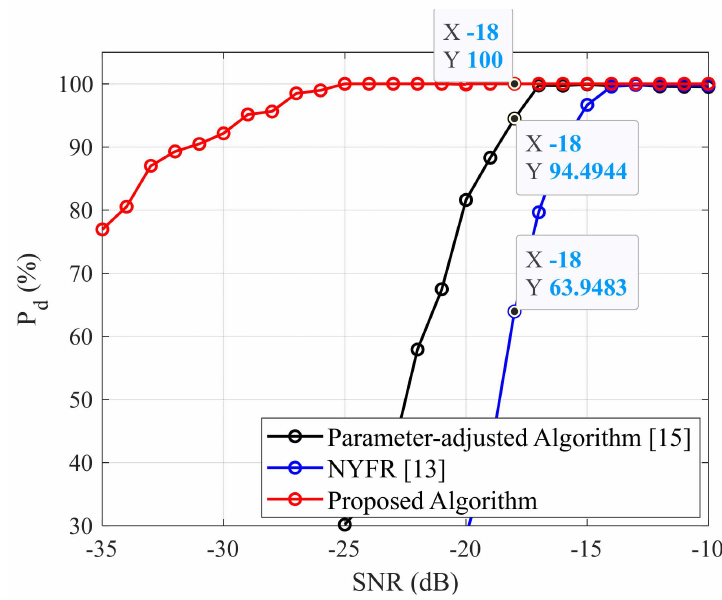
Figure 15. Detection probability of each method depending on the